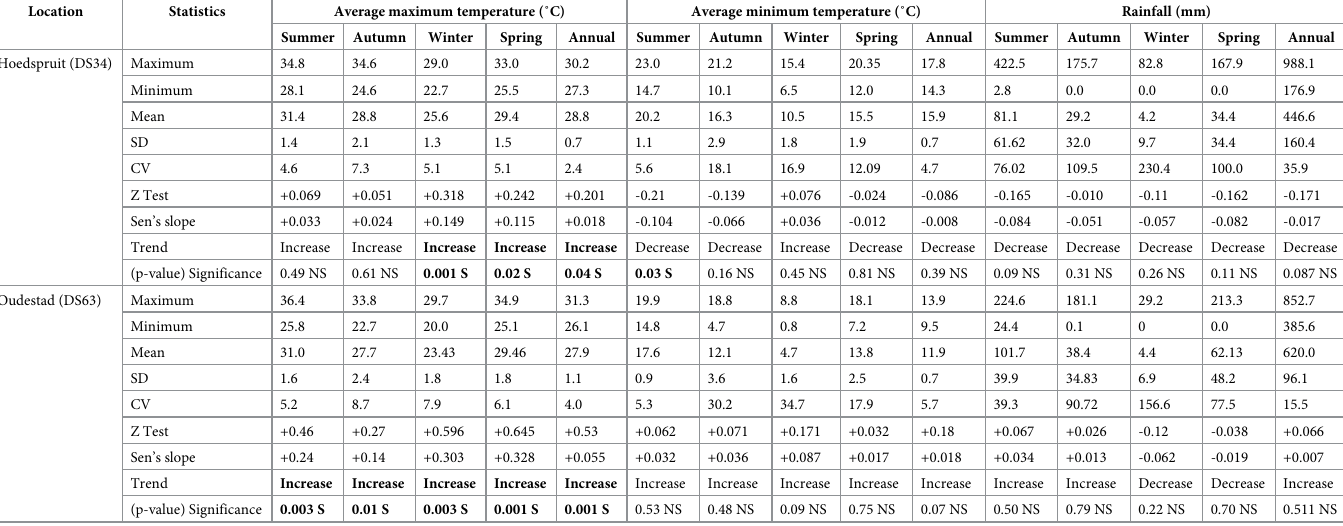
Table 5. Descriptive statistics and trend analysis of maximum, minimum temperature (˚C) and rainfall (mm).